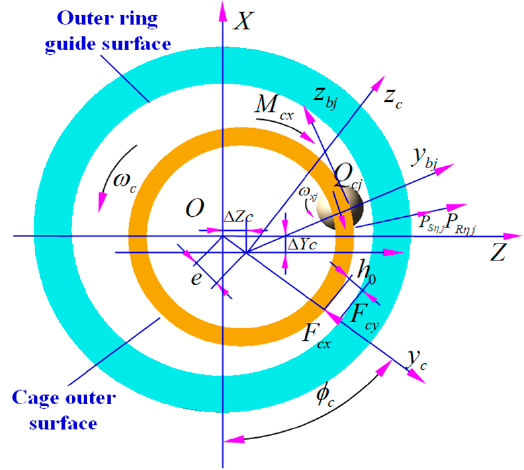
y c , z c directions; and M cx is the friction moment acting on the cage’s surface.